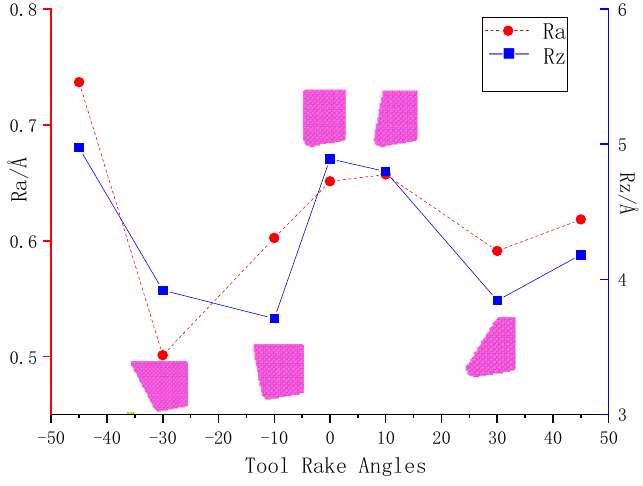
Figure 4. Workpiece surface roughness after machining with different rake angles.